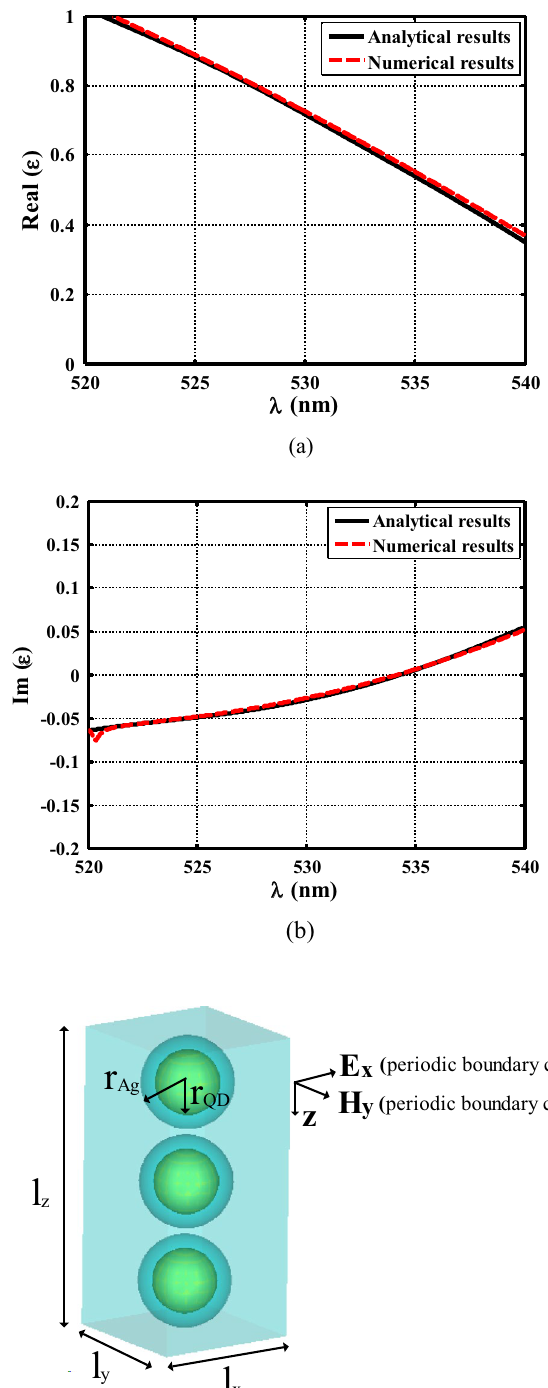
Figure 4. Real ( a ) and imaginary ( b ) parts of the effective permittivity of the composite medium including silver-coated CdSe/CdS quantum dots dispersed inside the polymeric host. ( c ) Simulation setup used to numerically retrieve the effective permittivity of the low index layer. r QD = 4 nm, r Ag = 5.8 nm , l x = l y = 18 nm and l z = 38